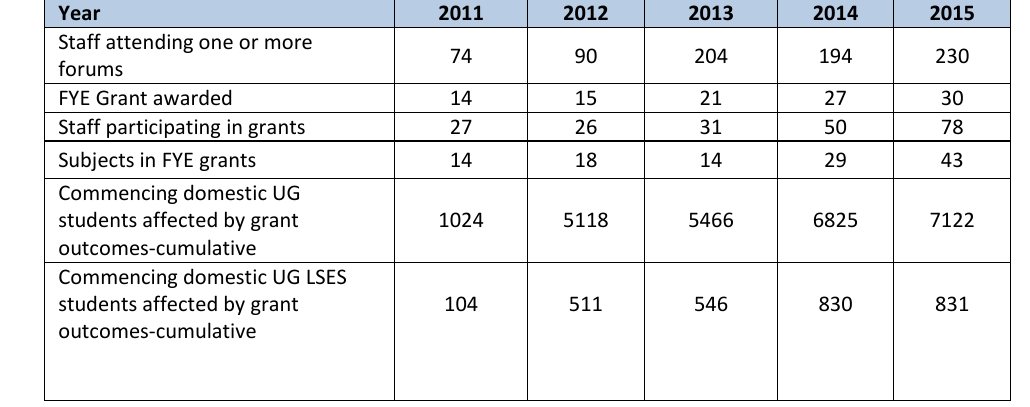
Table 1: Staff involvement in forums and grants, and subjects and students affected